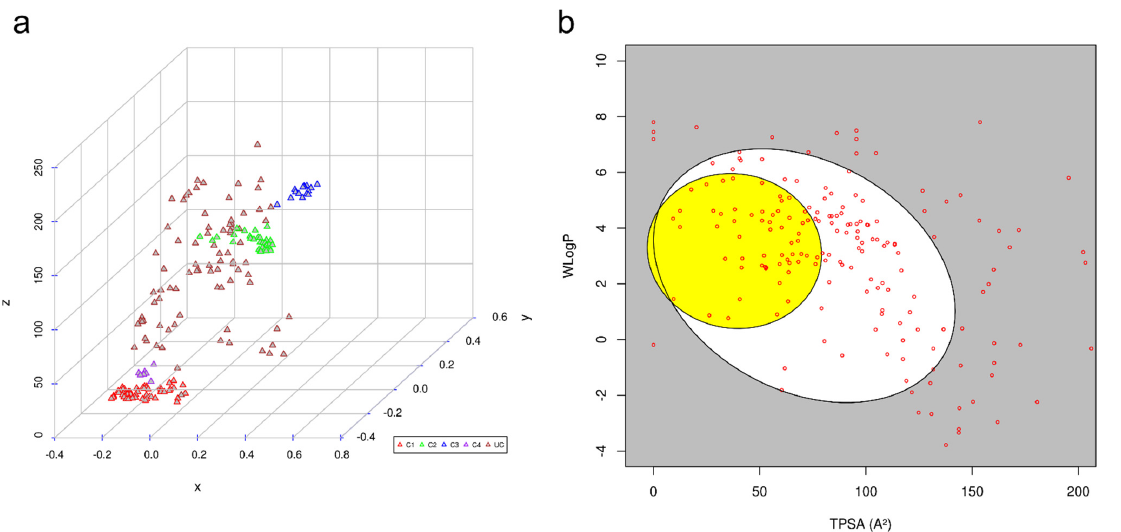
Figure 2. ( a ) Clustering results of molecules compiled from literature, where red-, green-, blue-, and purple-colored triangles represent Clusters 1–4. Unclustered molecules are represented as brown triangles; ( b ) graphical distribution of molecules compiled from literature as BOILED-Egg plot.